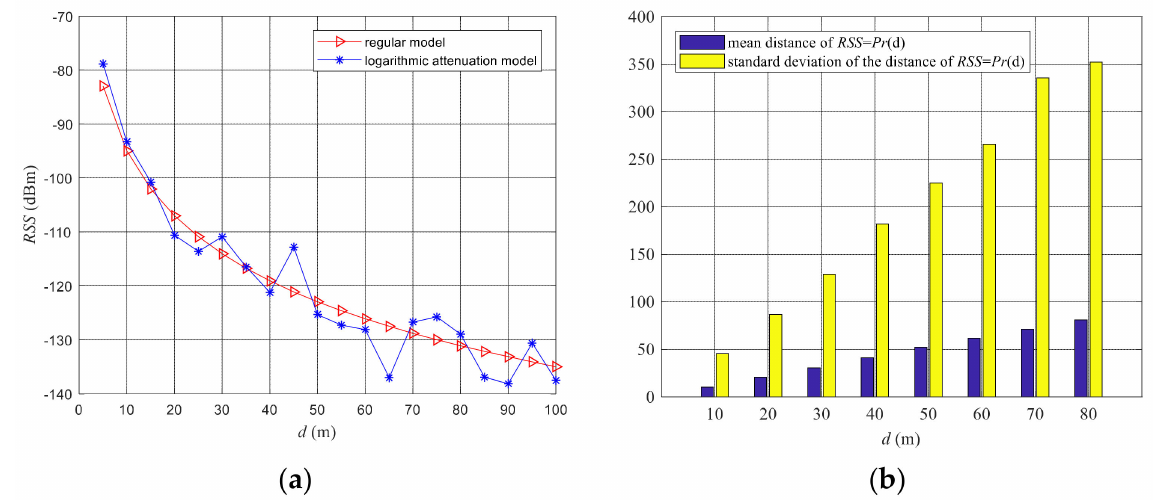
Figure 2. ( a ) Variation of signal strength with distances of the two models. ( b ) Histogram of statistical data on different distances ( η = 4, P t = 0 dBm, P L ( d 0 ) = − 55 dBm, d 0 = 1 m, σ =